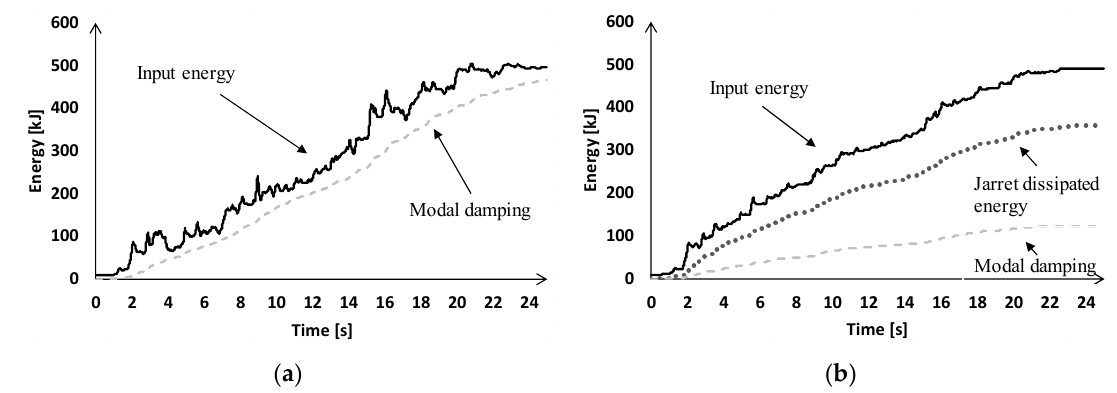
Figure 19. Energy diagrams for building B in: ( a ) as-built configuration and ( b ) after retrofit.